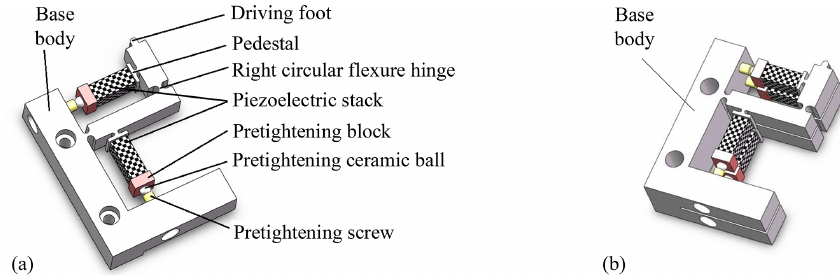
Figure 4. Diagram of stator. (a) Structure of stator with single driving foot and (b) structure of stator with double driving feet.